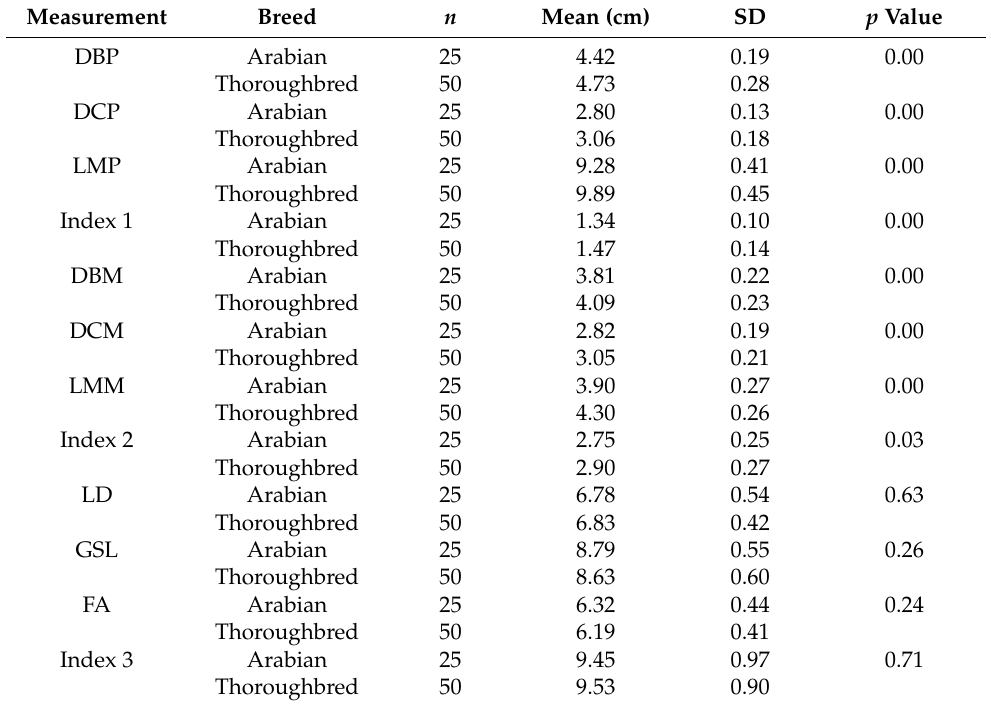
Table 2. Mean values of measurements, standard deviations, and p values determined for Arabian horses and Thoroughbred horses